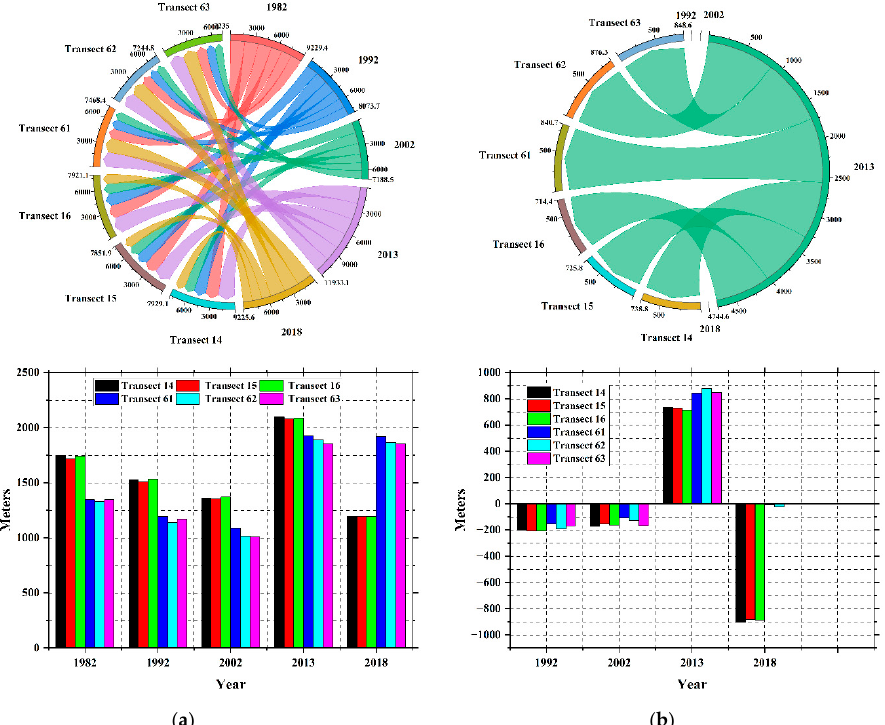
Figure 8. ( a ) Distance from baseline (m), ( b ) shoreline gain/loss in comparison to the last timeline (m).